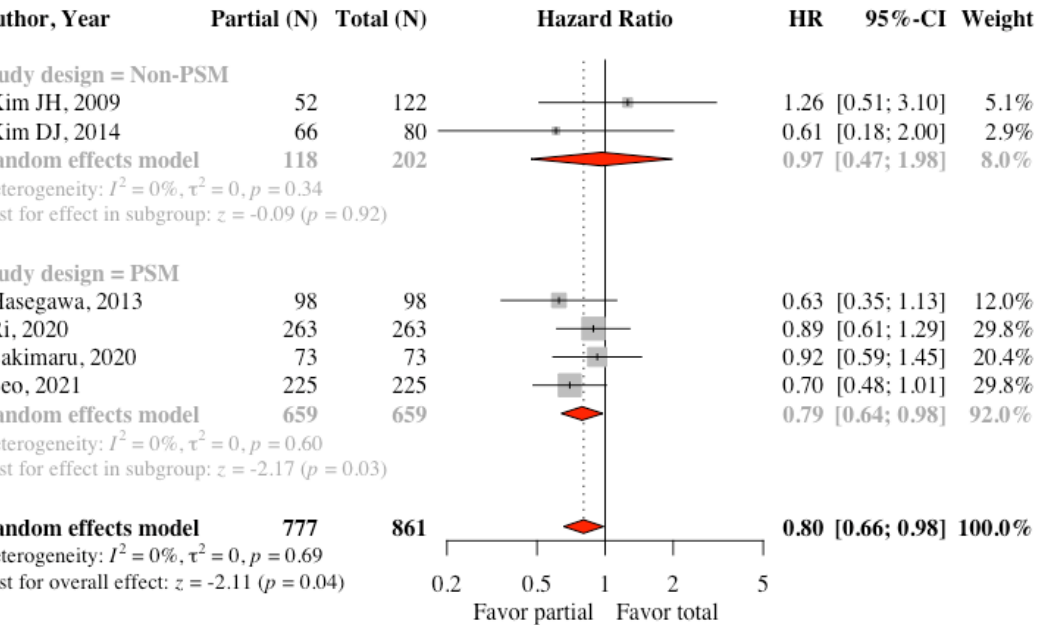
Figure 3. Forest plot comparing overall survival between the partial omentectomy and the total omentectomy group.